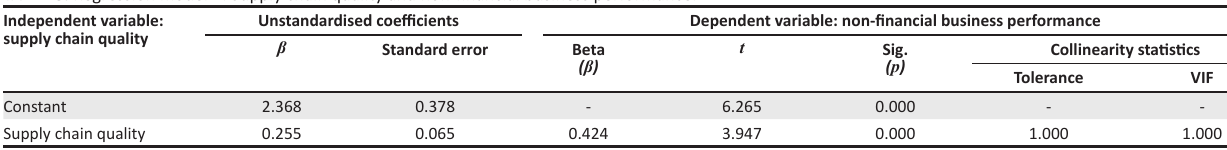
TABLE 8: Regression model 2: Supply chain quality and non-financial business performance. Independent variable: supply chain quality